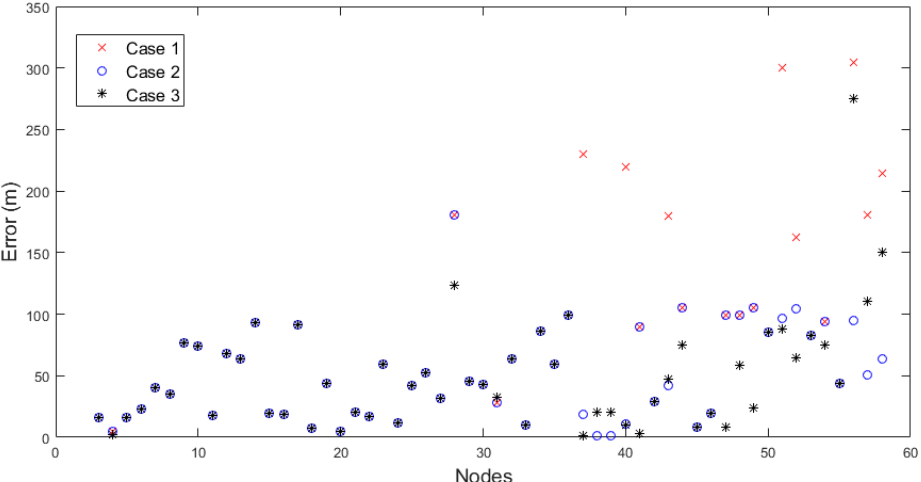
Figure 7. Location error for different fault positions.